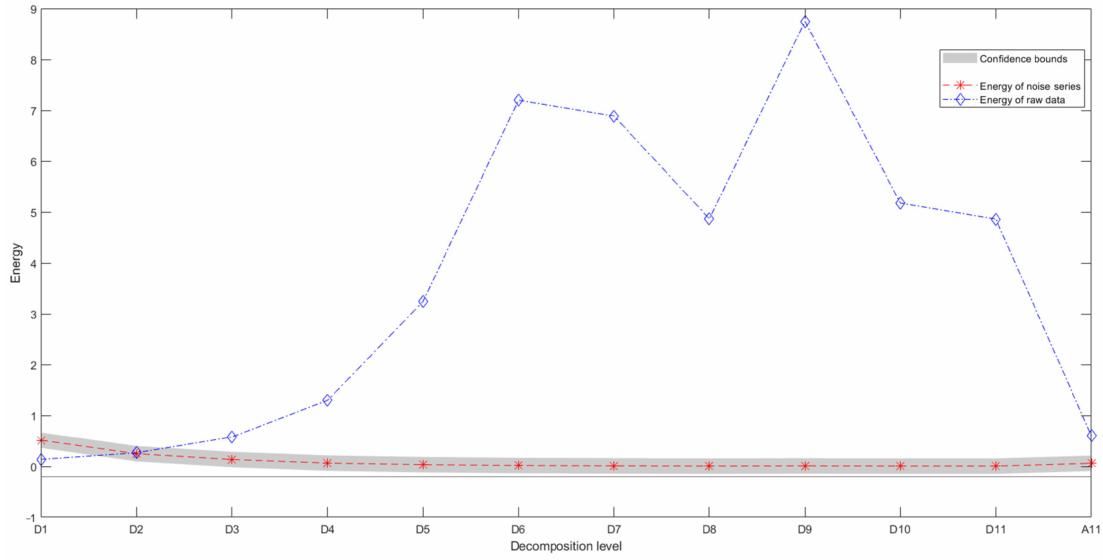
Figure 7. Energy of subseries.